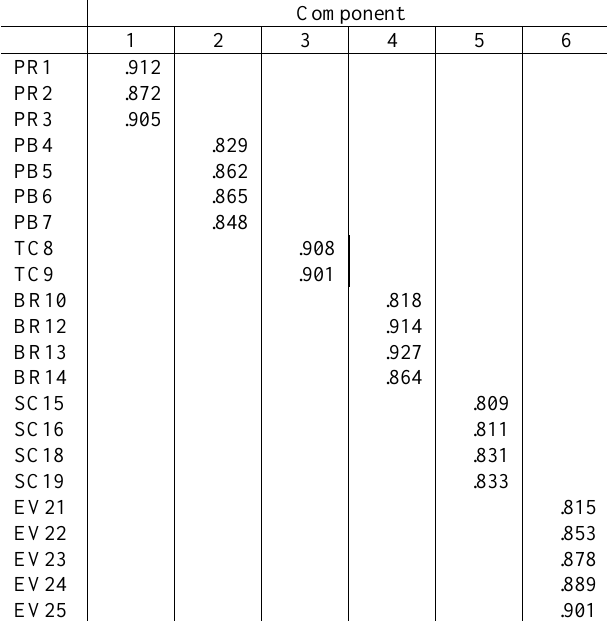
Table 4: Factor loadings of constructs